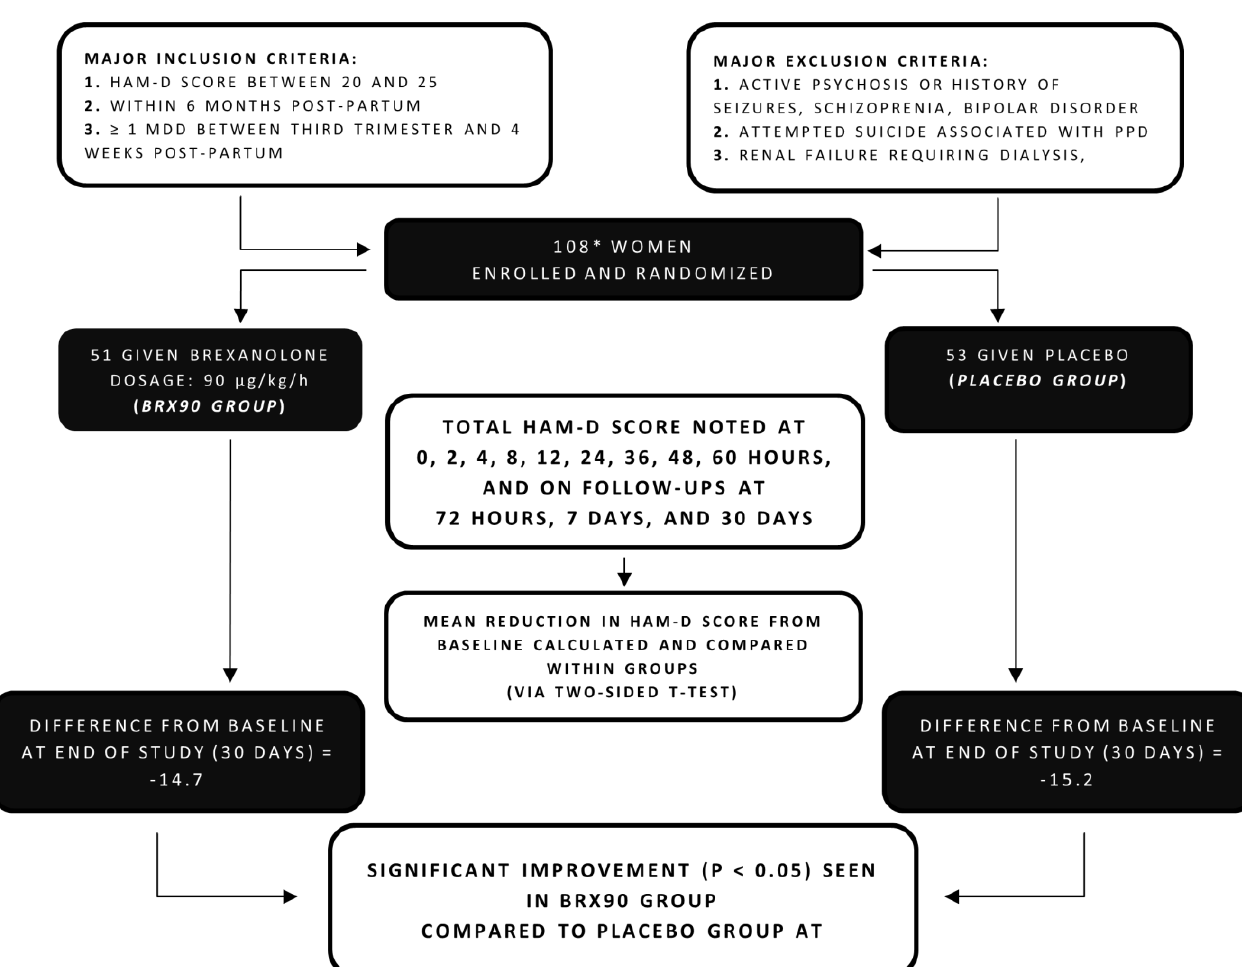
Figure 3. Flowchart summarizing methods and findings of randomized controlled trial (study 2) by Meltzer-Brody et al. 2018. * 108 participants were enrolled, of which 4 were not included in analysis for various reasons [14].